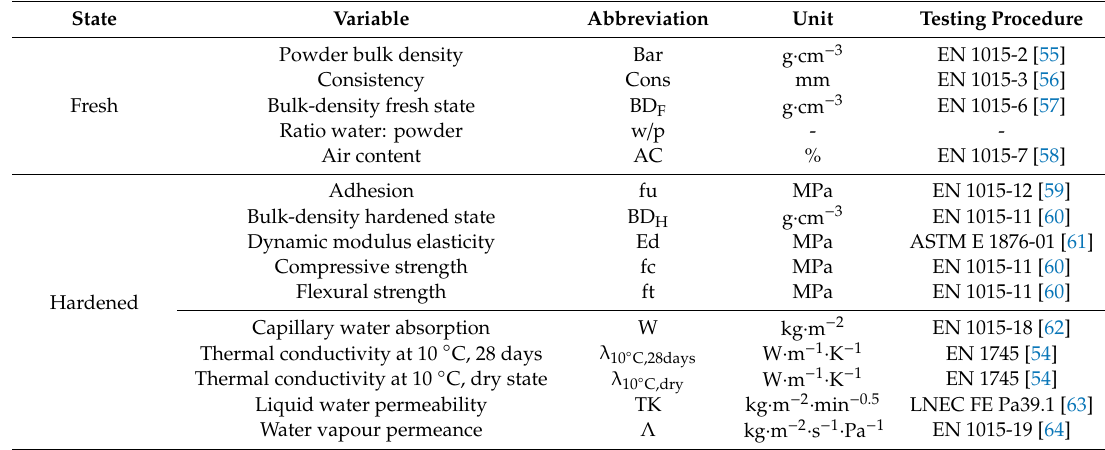
Table 1. Variables’ descriptions.